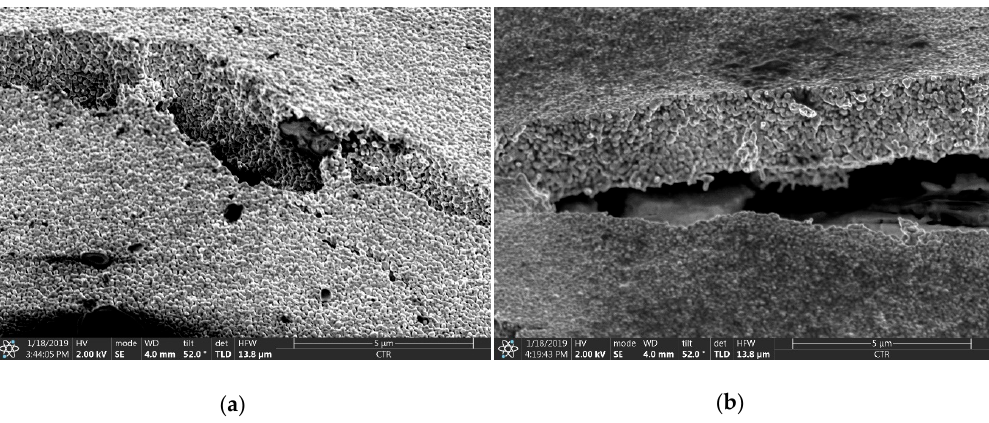
Figure 7. SEM images of the printed, cured and sintered Ag-layers on type 4 paper substrate; cracks in the printed layer on two different locations ( a ) and ( b ) become apparent; the size bar is 5 µm in length.